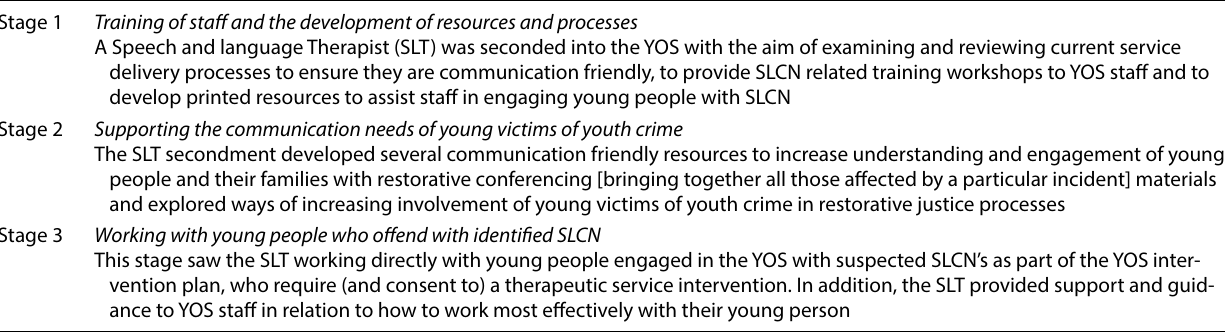
Table 1 Staged approach to incorporation of SLCN provision within the local authority YOS Stage